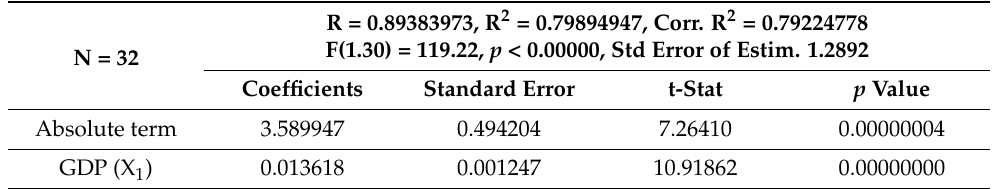
Table 2. Results of modeling the share of renewable energy sources in gross marginal energy consumption in Poland in 1991–2022 using a linear econometric model of one variable.